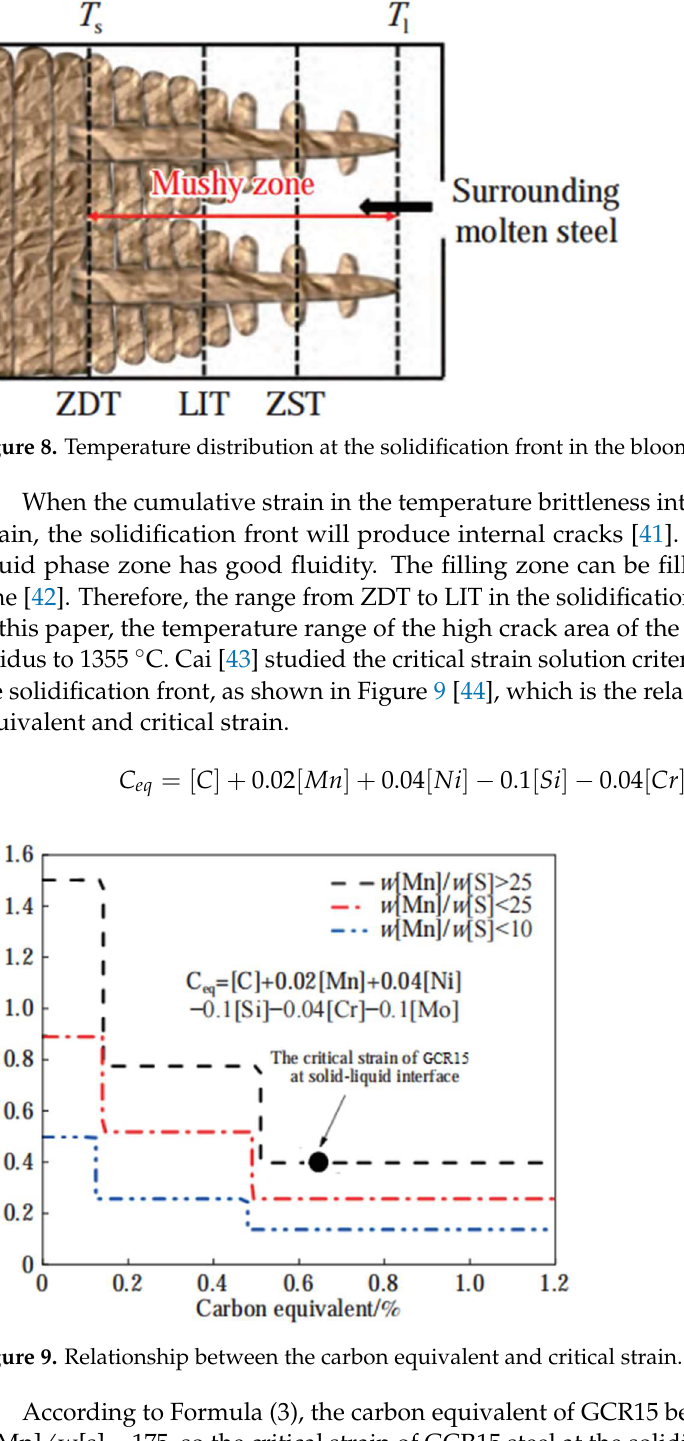
9 of 18 Figure 7. Variations of the temperature and solid fraction of bloom center of the case of casting speed of 0.45 m/min and average superheat of 26 °C. 3.3. Reduction Amounts of HR During the reduction process, plastic strain may occur at the solidification front. When the stress and strain exceed the critical value, the bloom solidification front forms an internal crack, which deteriorates the quality of the bloom. Therefore, the amount of